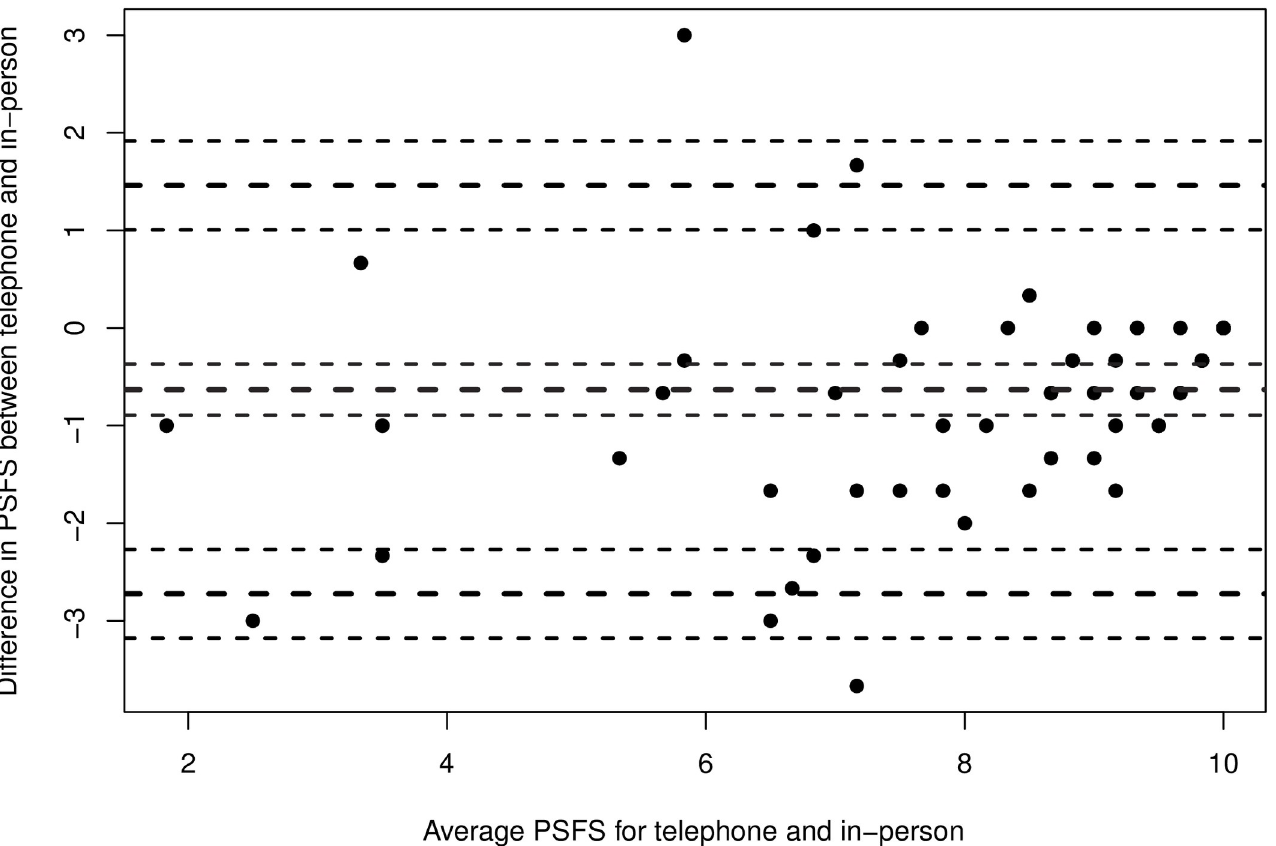
Fig 1. Bland Altman plot to display the difference between telephone and in-person administrations of the patient-specific functional